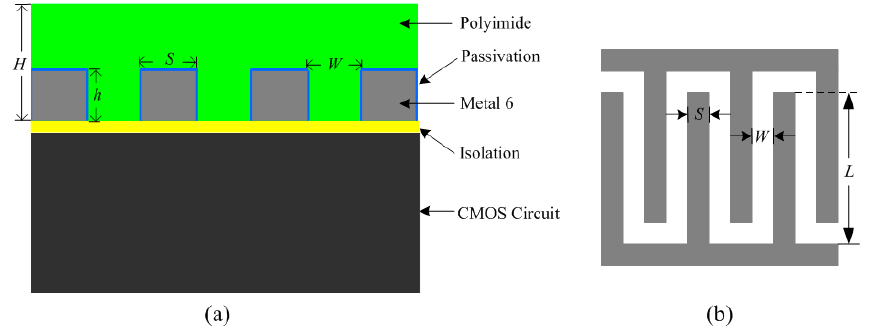
Figure 4. Proposed humidity sensor structure ( a ) humidity sensor structure; ( b ) top view of the humidity sensor